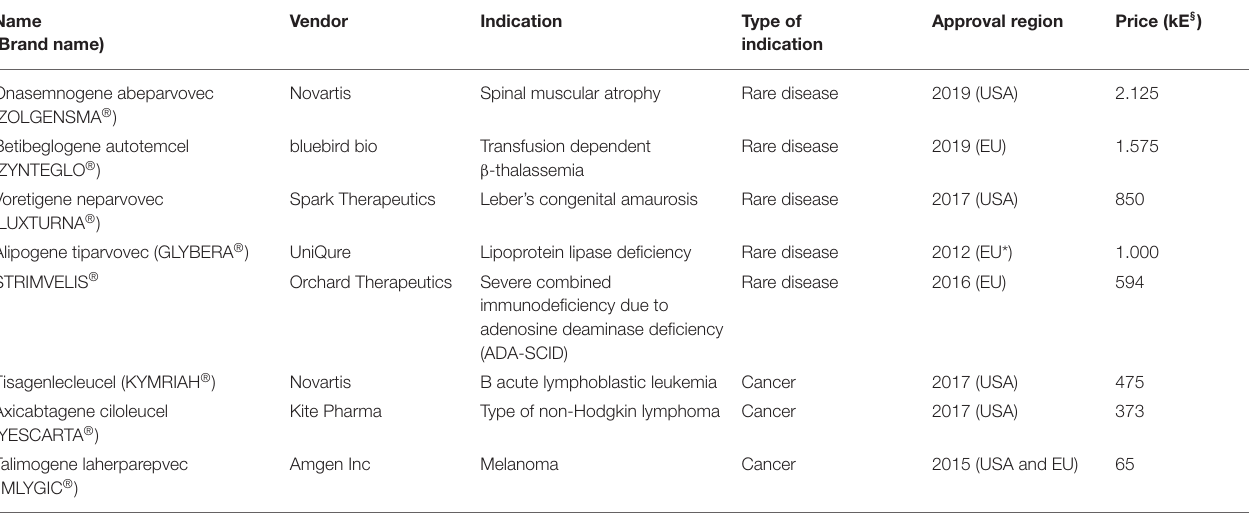
TABLE 1 | Gene therapy products that have acquired marketing